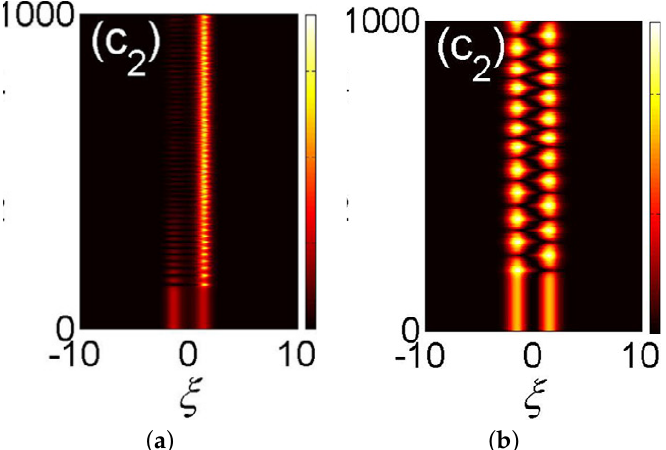
Figure 8. The perturbed evolution of unstable symmetric ( a ) and antisymmetric ( b ) solitons, pro- duced by simulations of Equation (1) with the double-well potential (34), Lévy index α = 1.1, and nonlinearity strength g = + 1 ( a ) and − 1 ( b ). The propagation constants of the unstable symmetric and antisymmetric solitons are µ = − 1.62 and µ = − 1.12, respectively. Reprinted with permission from Reference [42]. Copyright 2020